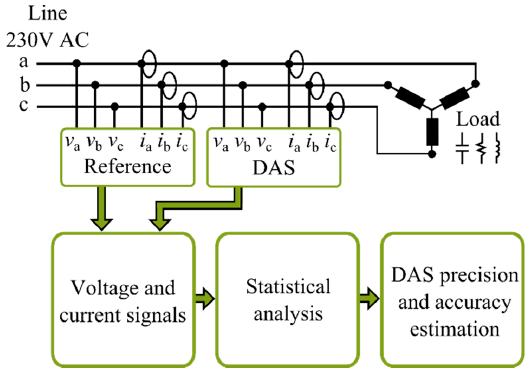
Figure 1. Calibration flow diagram.